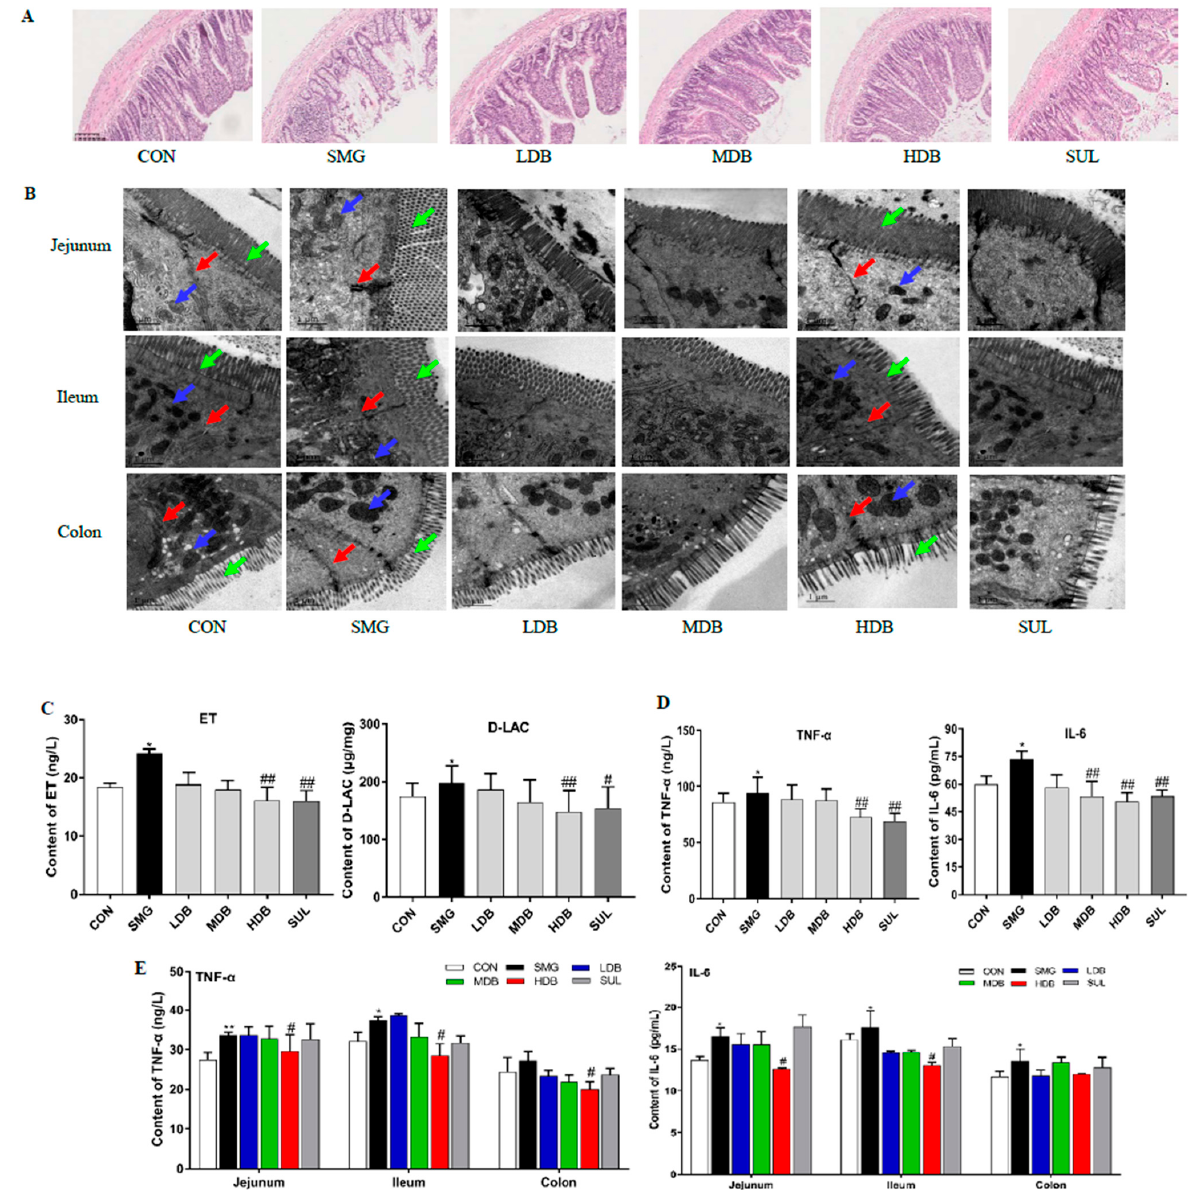
Figure 1. Dragon’s Blood (DB) attenuated intestinal epithelial barrier injury induced by simulated microgravity group (SMG) in rat intestine. ( A ) HE staining of rat ileum tissues in different groups (ruler scale of 100 µ m). ( B ) ultrastructure of rat jejunum, ileum, and colon tissue as observed by TEM (green, red and blue arrows represent microvilli, intercellular space and mitochondrial, ruler scale of 1 µ m). ( C ) permeability of rat intestinal barrier reflected by D-LAC and ET ( n = 9). ( D ) the protein levels of TNF- α and IL-6, in rat plasma as determined by ELISA ( n = 9). ( E ) the protein levels of TNF- α and IL-6 in rat jejunum, ileum, and colon tissues as determined by ELISA ( n = 9). Note: * p < 0.05 and ** p < 0.01, compared with CON group. # p < 0.05 and ## p < 0.01, compared with SMG group. Western blotting showed that occludin, endothelial-cadherin (E-cadherin) and β - 2.3. DB Protected Intestinal Barrier by Increasing the Expression of TJ and AJ Proteins in SMG Rats catenin levels in jejunum and ileum mucosa of SMG rats were dramatically decreased Tight junction (TJ)and adherens junction (AJ) play very important roles in maintain- ( p < 0.05) compared with those in the CON group. Zona occluden-1 (ZO-1) and claudin-1 ing the integrity of the intestinal barrier [39]. In this study, the expressions of three TJ did not show significant change in the ileum mucosa of SMG rats. HDB treatment proteins (zona occluden-1, occludin, claudin-1) and two AJ proteins (endothelial-cadherin and β -catenin) were determined by western blotting. Since the internal controls, such as